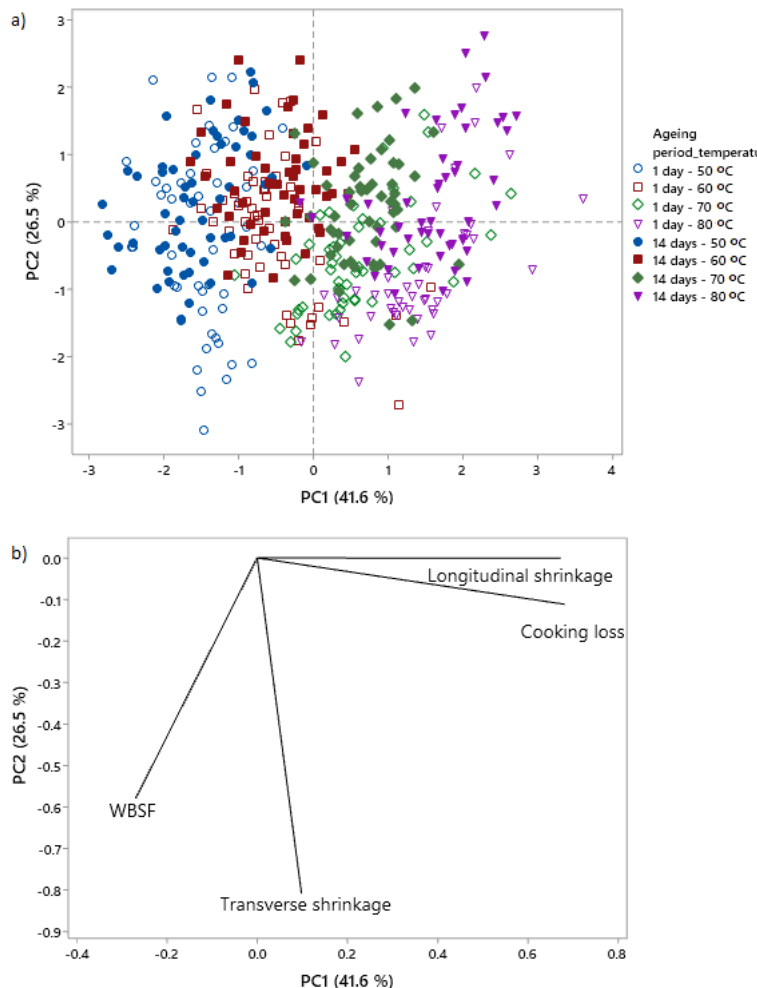
Figure 9. Relationship between the physical changes (WBSF, cooking loss, shrinkage) of bovine semitendinosus , biceps femoris and psoas major . Principal component analysis (PCA) analysis of the physical changes of bovine semitendinosus , biceps femoris and psoas major with ageing and cooking. ( a ) Score plot labelled by ageing period and temperature; ( b ) loading plot corresponding to the PCA analysis in ( a ).